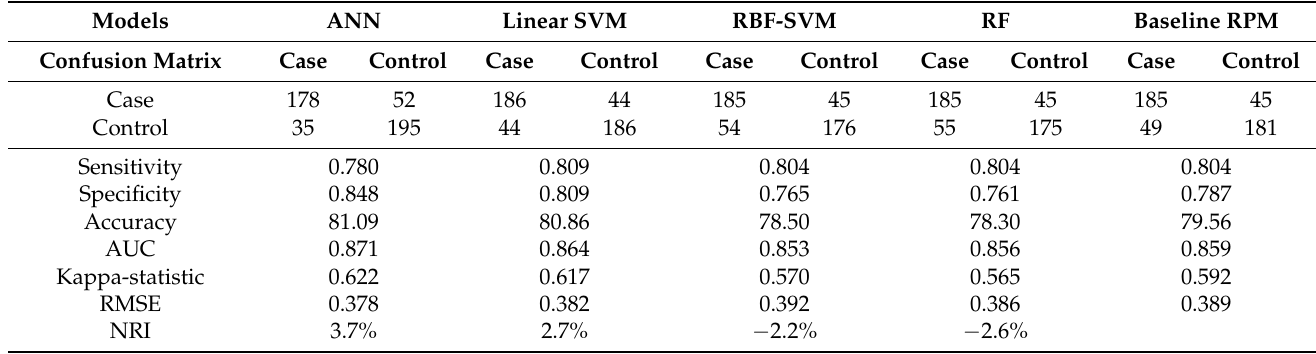
Table 2. Performance of baseline and ML-based